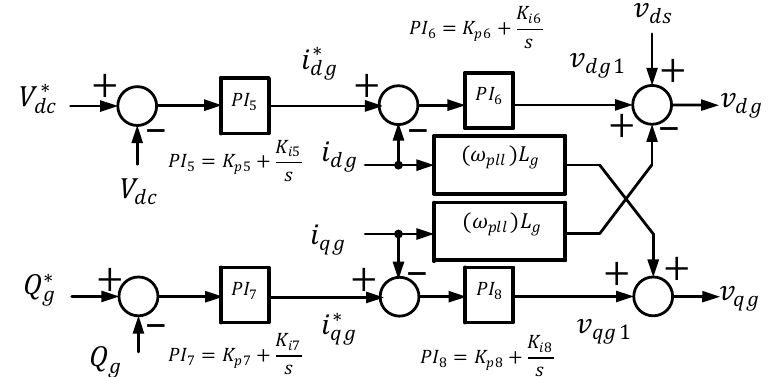
Figure 8. Grid-side converter Figure 8. Grid ‐ side converter controller.